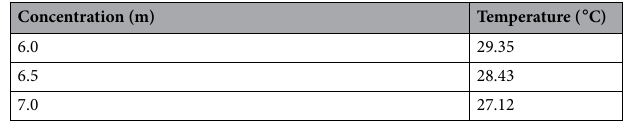
Table 1. Temperatures of sudden change in the permittivity spectra for different concentrations of